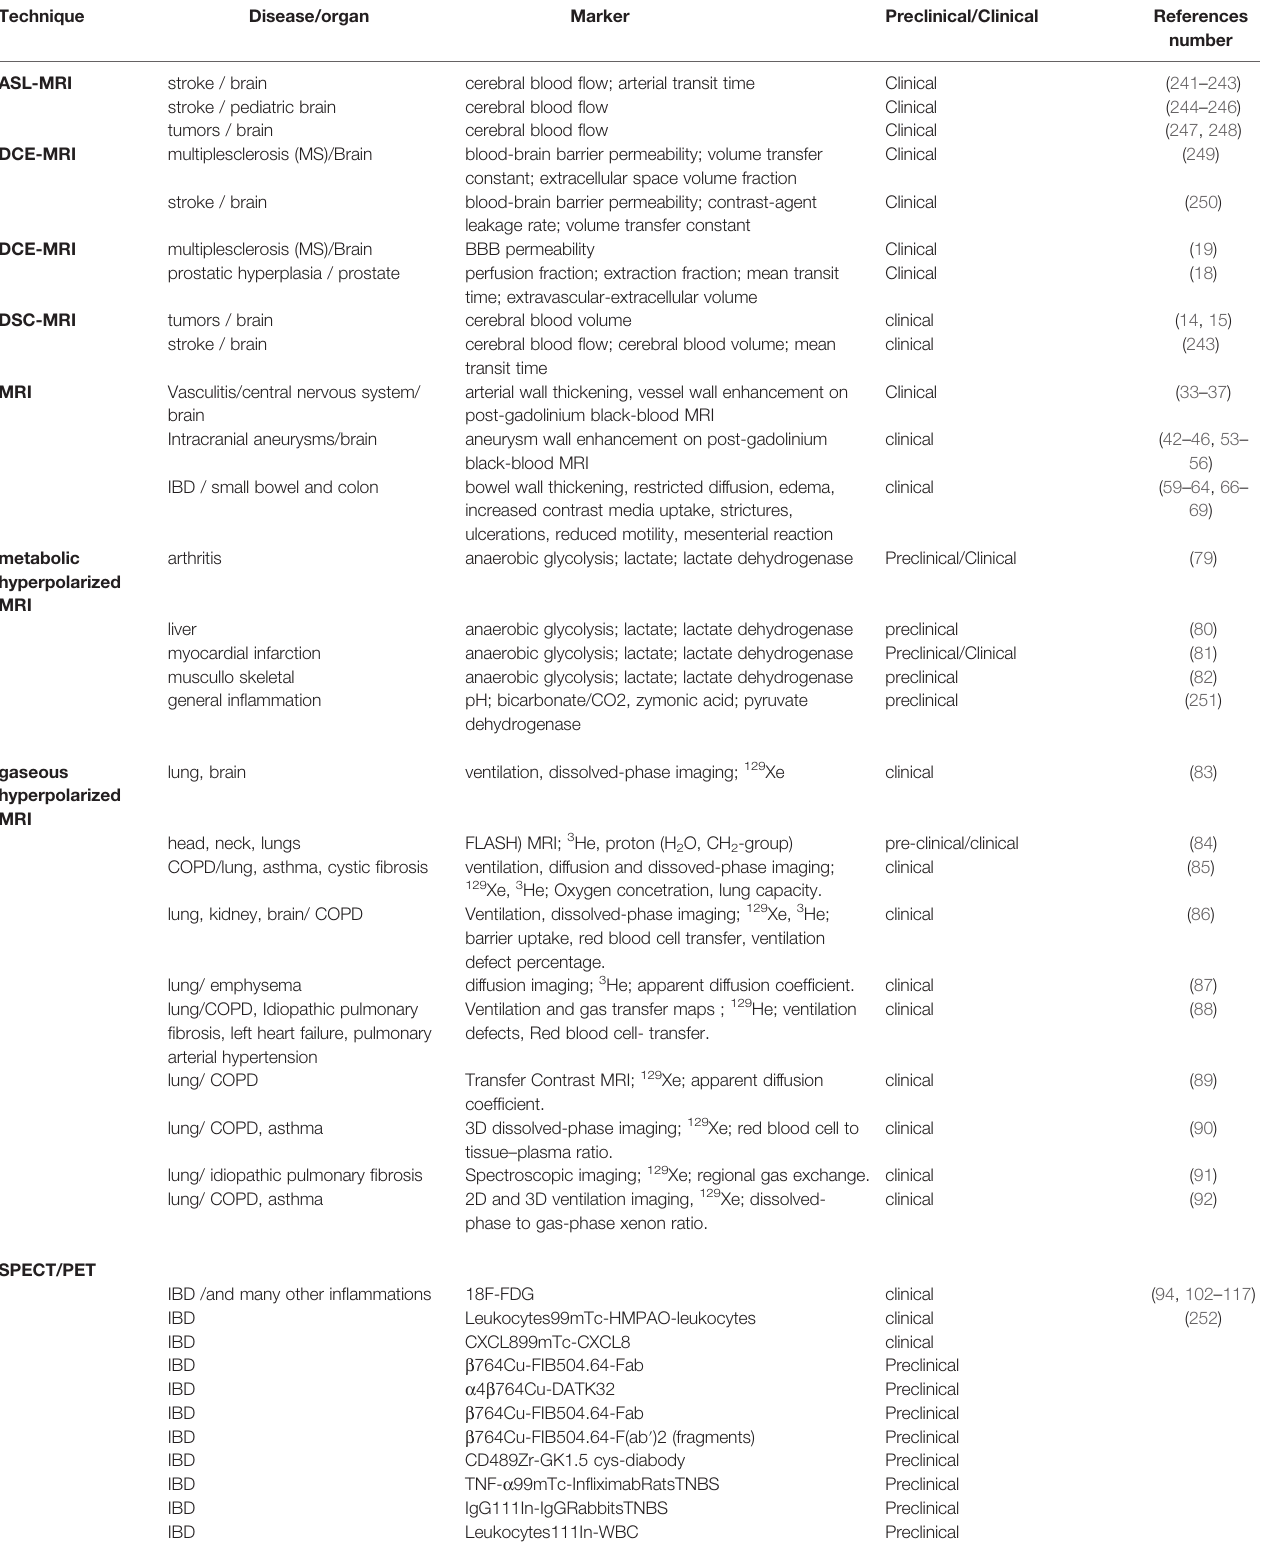
TABLE 1 | Current clinical and relevant assortment of potential preclinical tracers of different imaging modalities have been gathered to the table.